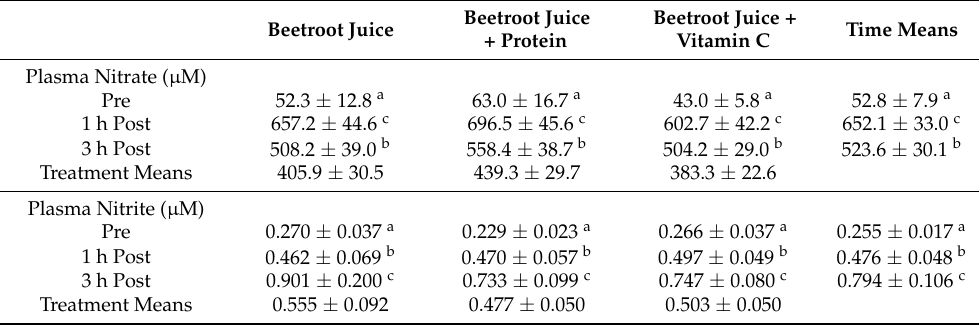
Table 2. Non-transformed intervention means for plasma nitrate and nitrite at pre- and 1 h and 3 h post-consumption of the intervention. Values for pre, 1 h post and 3 h post are mean ± standard error of the mean. The Time Means and Treatment Means are estimated marginal means ± standard error of the mean. All analysis were performed on log-transformed values for plasma nitrate and nitrite, but the non-transformed values are presented for ease of reader interpretation. Values with different superscript letters within a column were statistically significantly different from each